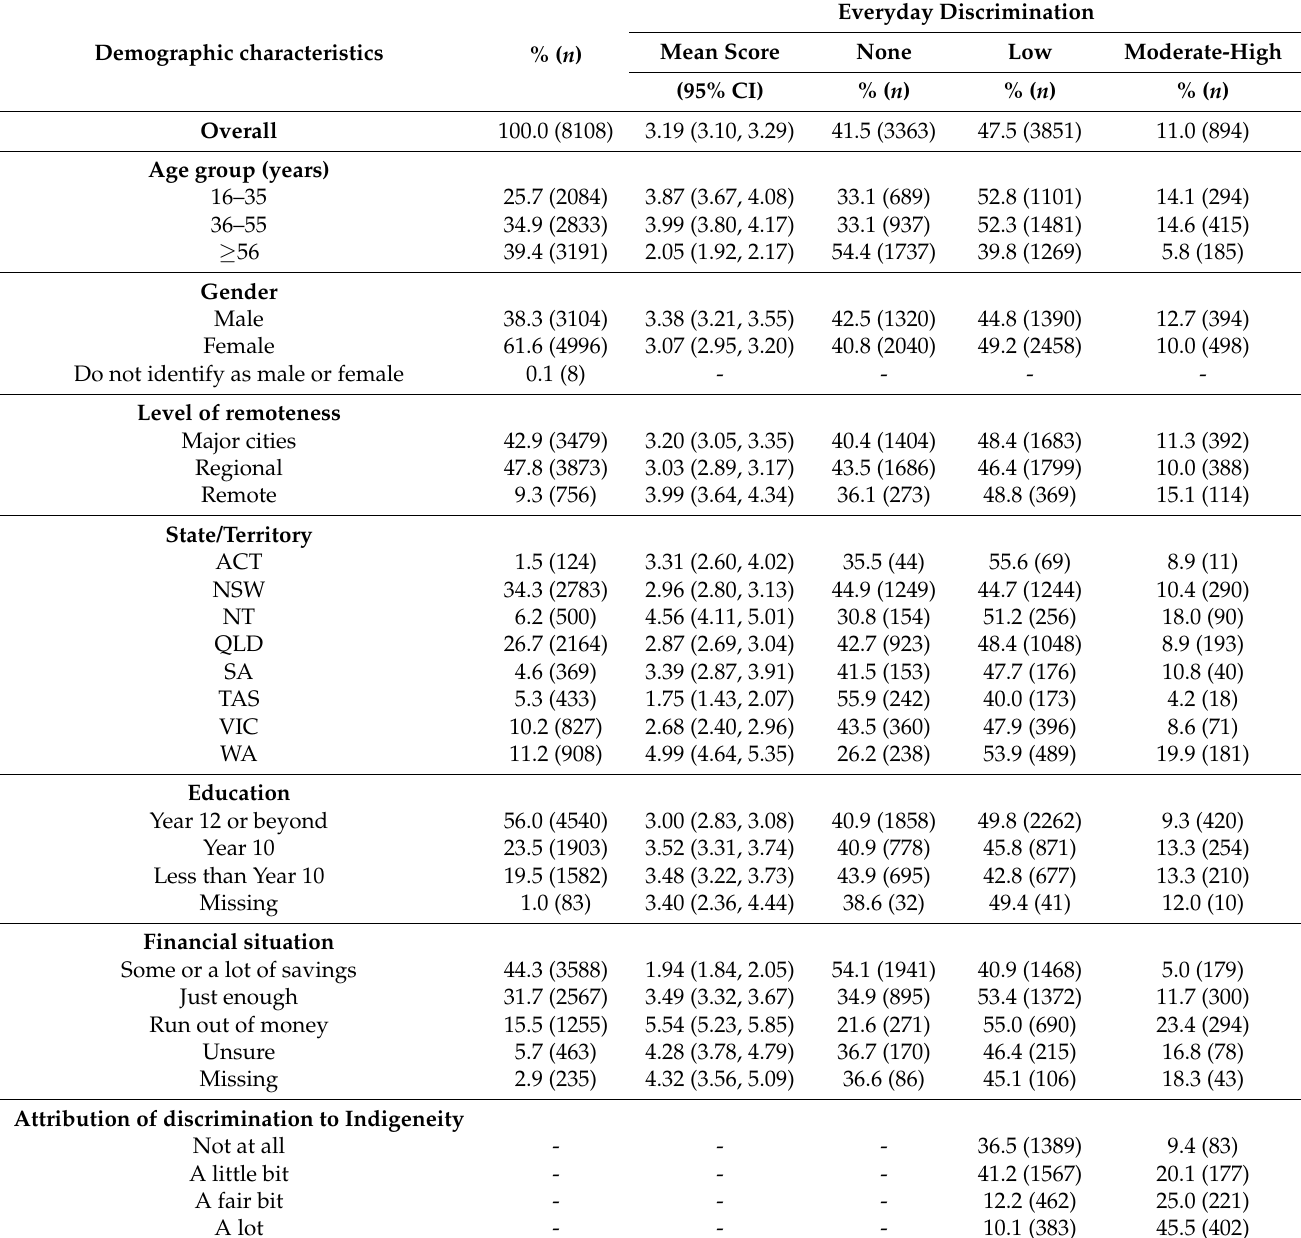
Table 1. Demographic characteristics and experiences of everyday discrimination in the sample ( n = 8108), and extent of attribution to